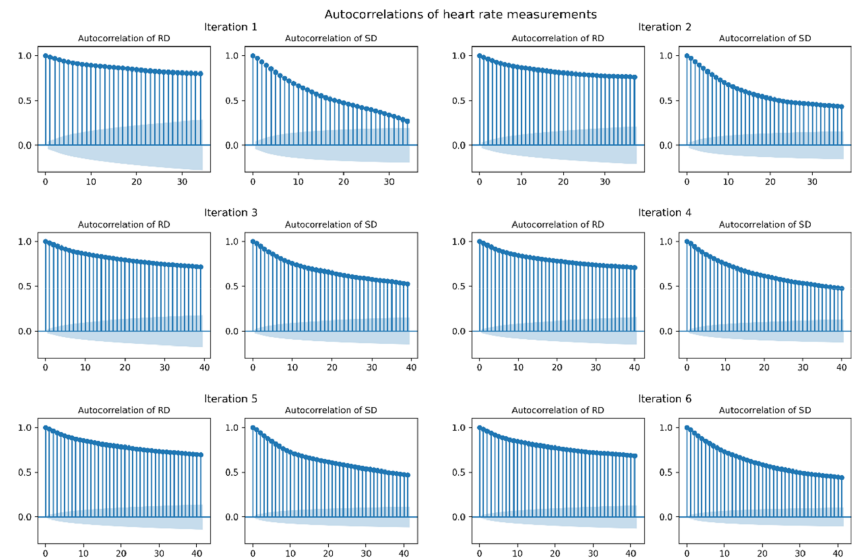
Figure 7. Autocorrelation plots of heart rate measurements for each iteration. In the right of each iteration, the autocorrelation plot of the RD data can be seen and on the left, the autocorrelation plot of SD.